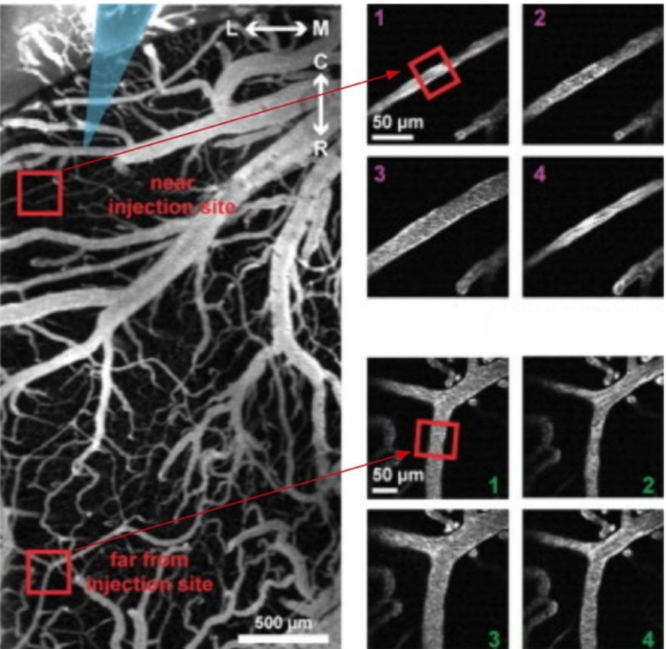
Figure 4. In vivo two-photon images of rat surface vasculature depicting vessel responses to 4-AP- induced ictal activity at different time points ( 1: injection, 2: seizure onset, 3: maximum dilation, 4: restoration to baseline ). The upper inset images demonstrate vasodilation near the seizure focus at the time of seizure onset ( 2 ), subsequent propagation ( 3 ) and restoration to baseline ( 4 ). The lower inset images demonstrate vasoconstriction away from the seizure focus at onset ( 2 ), followed by dilation at a later point ( 3 ), before restoring to baseline ( 4 ). Scale bars: 500 µ m (main image) and 50 µ m (inset images). Adapted from “Preictal and ictal neurovascular and metabolic coupling surrounding a seizure focus” (Zhao et al., The Journal of Neuroscience , 2011 [59]). This figure has been modified. Creative Commons license: https://creativecommons.org/licenses/by/4.0/ (accessed on 20 November